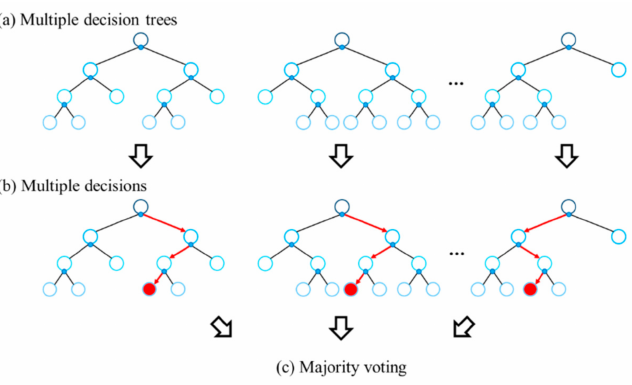
Figure 6. Schematic of random forest composed of multiple decision trees. ( a ) Multiple decision trees with different kinds of scenarios; ( b ) multiple decisions according to the trees; ( c ) final decision based on majority voting